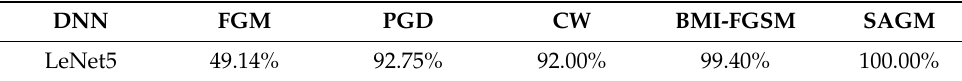
Table 1. Attack Success Rate on the MNIST Dataset.